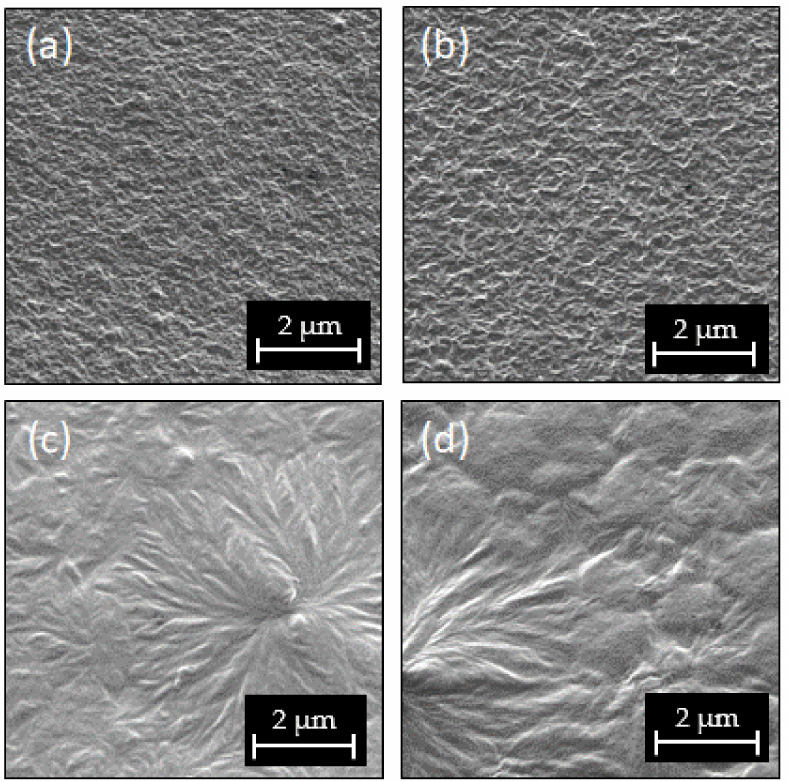
Figure 1. Secondary electron images of films processed from different solvent solutions: ( a ) Acetone; ( b ) MEK; ( c ) DMF; ( d )